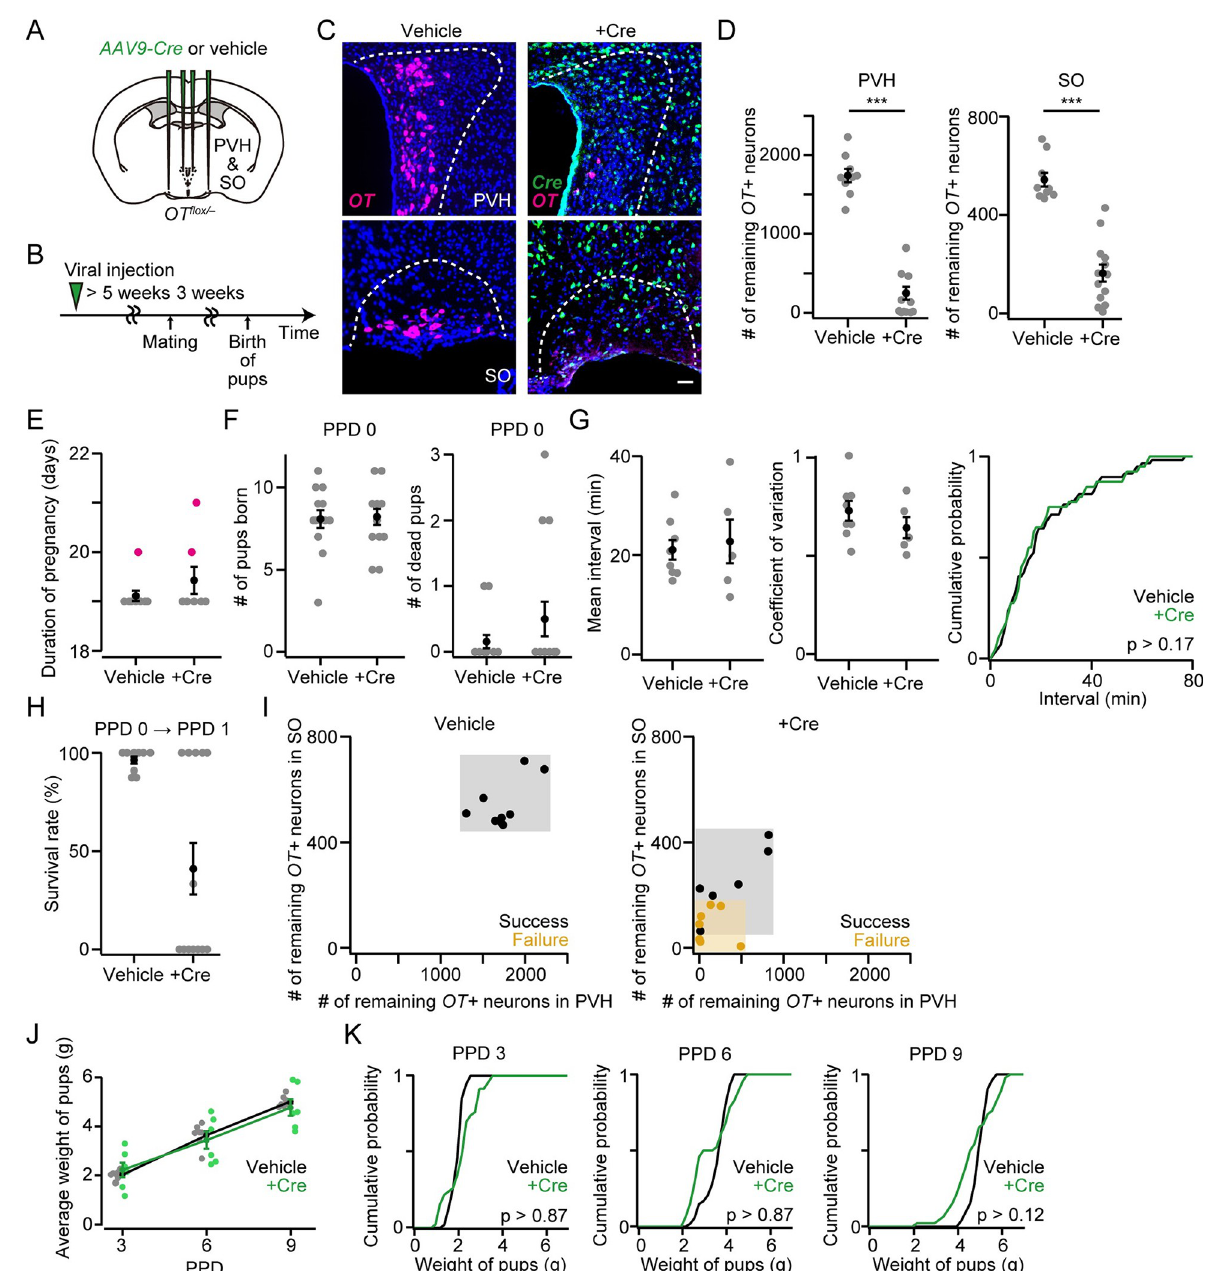
Fig 1. Grossly normal parturition and abnormal pup survival in OT cKO mothers. (A) Schematic of the viral injection. AAV-Cre or vehicle was injected into both the bilateral PVH and SO. (B) Schematic of the timeline of the experiment. (C) Representative coronal sections. OT and Cre in situ staining are shown in magenta and green, respectively. Blue, DAPI. Scale bar, 20 μ m. (D) Number of remaining OT + neurons in the PVH (left) or SO (right). ��� p < 0.001, two-sided Mann–Whitney U- test. n = 9 and 13 mothers for vehicle and +Cre, respectively. (E) The duration of pregnancy was not statistically different (p > 0.56, two-sided Mann–Whitney U- test). n = 9 and 7 for vehicle and +Cre, respectively. Magenta dots indicate stillbirth. (F) Left, number of pups born from the vehicle or +Cre mothers was not statistically different (p > 0.90, two-sided Mann–Whitney U- test). Right, number of pups that died within the day of delivery (PPD 0). n = 13 and 14 mothers for vehicle and +Cre, respectively. (G) Left, mean pup delivery interval in each dam. Middle, coefficient of variation showing the interval variability. Right, cumulative probability of interval. n = 59 and 40 pups for vehicle and +Cre, respectively. The p-value is shown in the panel (Kolmogorov–Smirnov test). n = 8 and 5 mothers for vehicle and +Cre, respectively. (H) Survival rate of pups at PPD 1. Note that pups that died at PPD 0 (F) were excluded. n = 9 and 13 mothers for vehicle and +Cre, respectively. (I) Relationship between the success (black dots) or failure (orange dots) of raising pups at PPD 1 and the number of remaining OT+ neurons in the PVH (x-axis) or SO (y-axis). Data from the same mice shown in D. (J) Average weight of pups per dam. Mothers in which all pups were dead at PPD 1 were excluded from +Cre. No statistical difference was found in vehicle and +Cre (two-way ANOVA with repeated measurements). n = 7 and 6 for